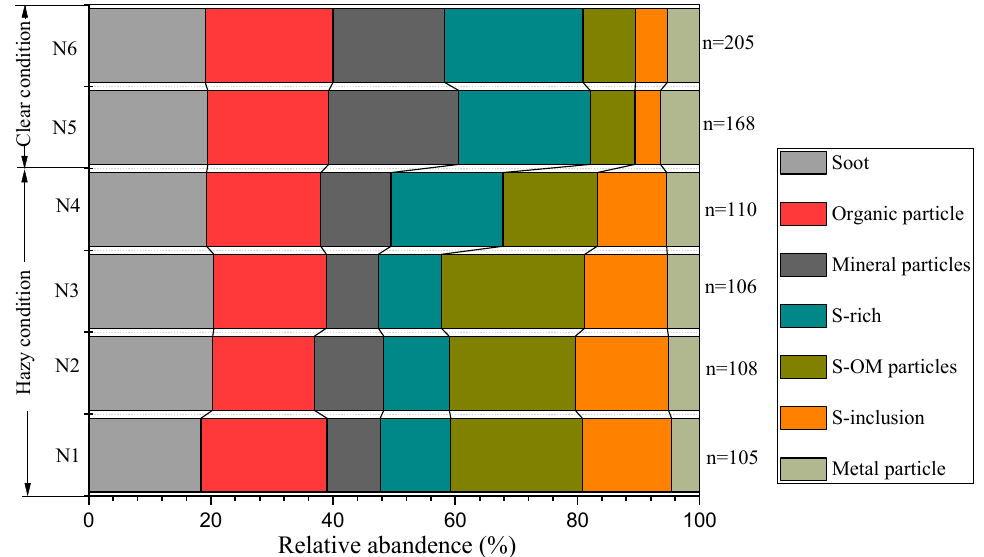
Figure 5. Relative abundance of each type of particle at the roadside site. The numbers above the bars are the total amount of particles analyzed in the samples. N marks the roadside site.